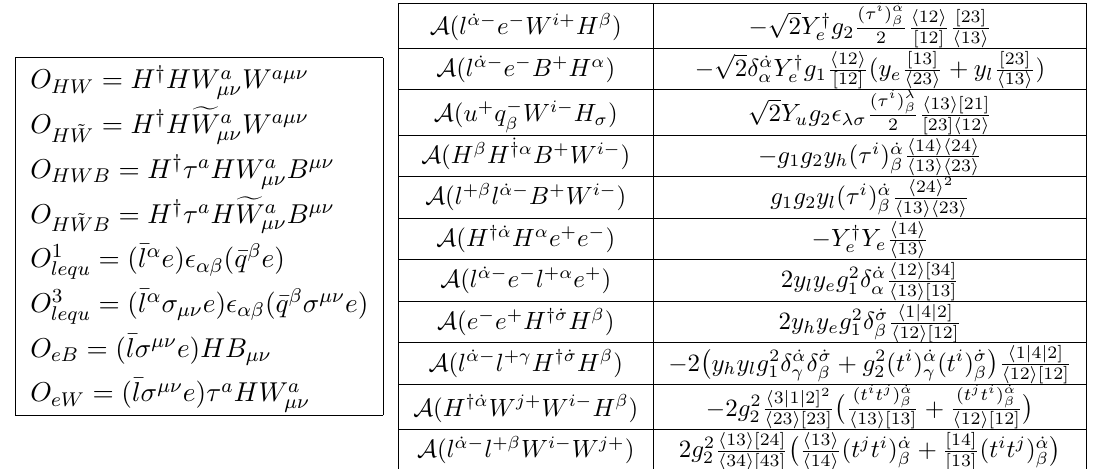
Table 2 . Left: dimension 6 operators that contribute to the running of O eW ; right: expressions of SM amplitudes used in calculating ˙ C eW